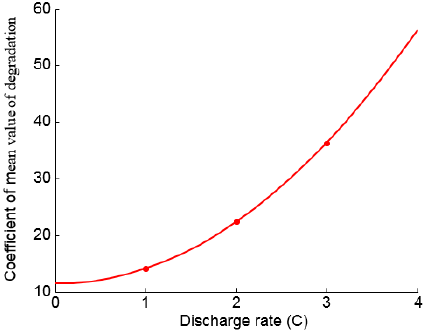
Figure 5. Capacity degradation curves at different discharge rates.